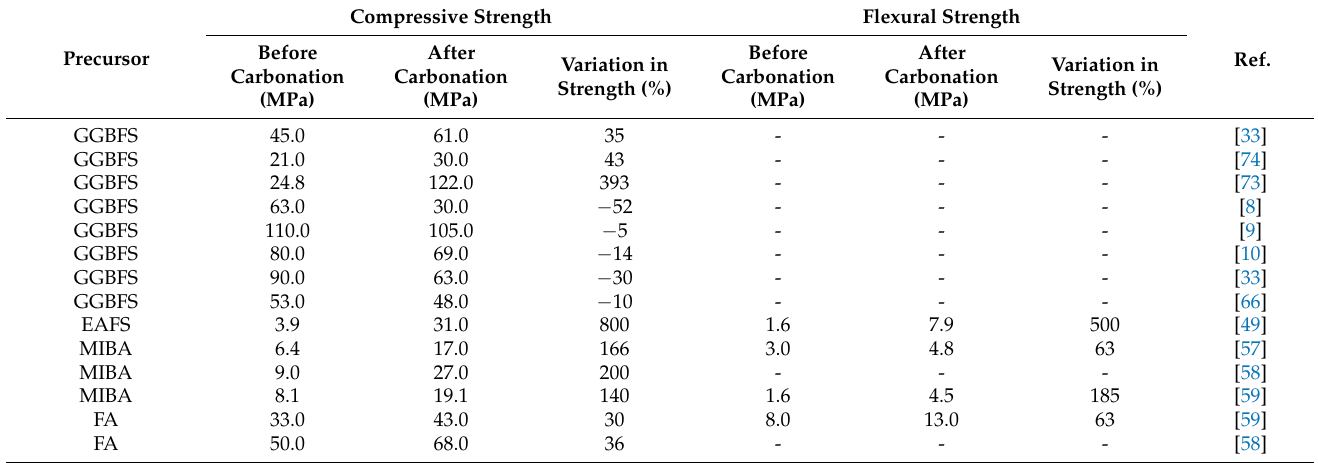
Note: values in MPa were rounded to the nearest decimal place, and values representing percentages were rounded to the nearest whole number. Positive variation in strength represents strength increase, while a negative percentage variation indicates a